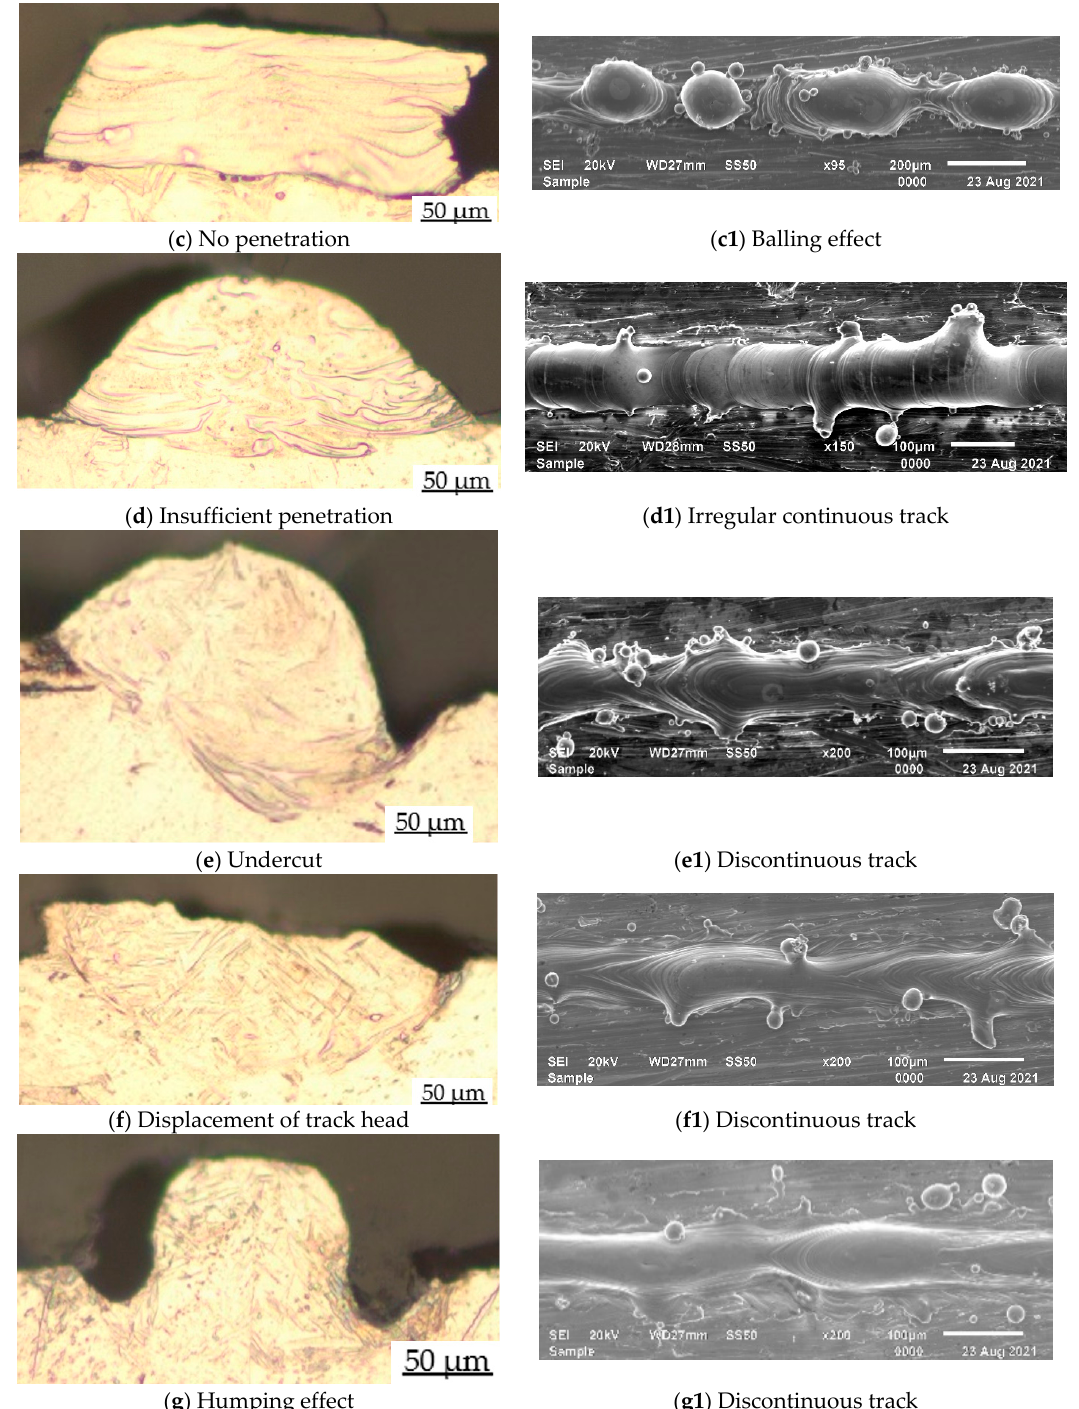
Figure 3. Geometry and morphology of the fused powder tracks at various process parameters, ( a )